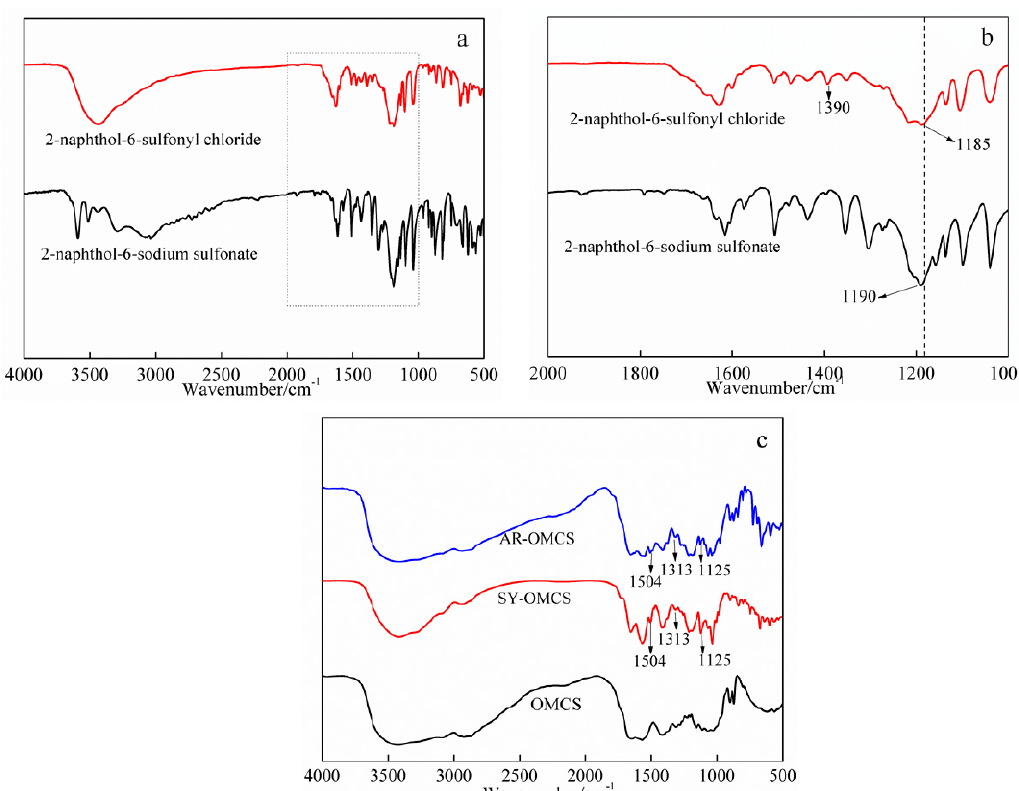
Figure 1. FT-IR spectra of 2-naphthol-6-sodium sulfonate and 2-naphthol-6-sulfonylchloride in the wavenumber range 500–4000 cm − 1 ( a ) and in the wavenumber range 1000–2000 cm − 1 ( b ); and OMCS, SY-OMCS and AR-OMCS ( c ).